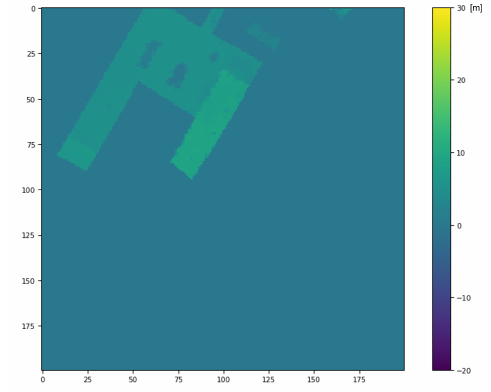
Figure 4. 3D change detection map obtained through difference of the DSMs (see Figure 3), after the manual removal of the noise. The colour bar is expressed in meters